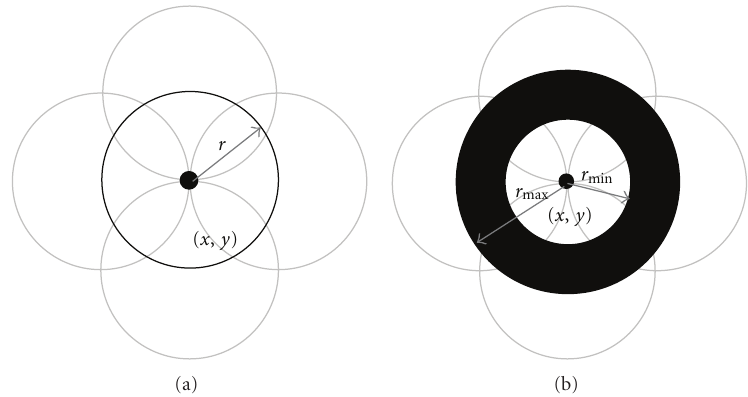
Figure 2: Idea of voting: (a) classical CHT, (b) CHT with multiple radii in one parameter space.